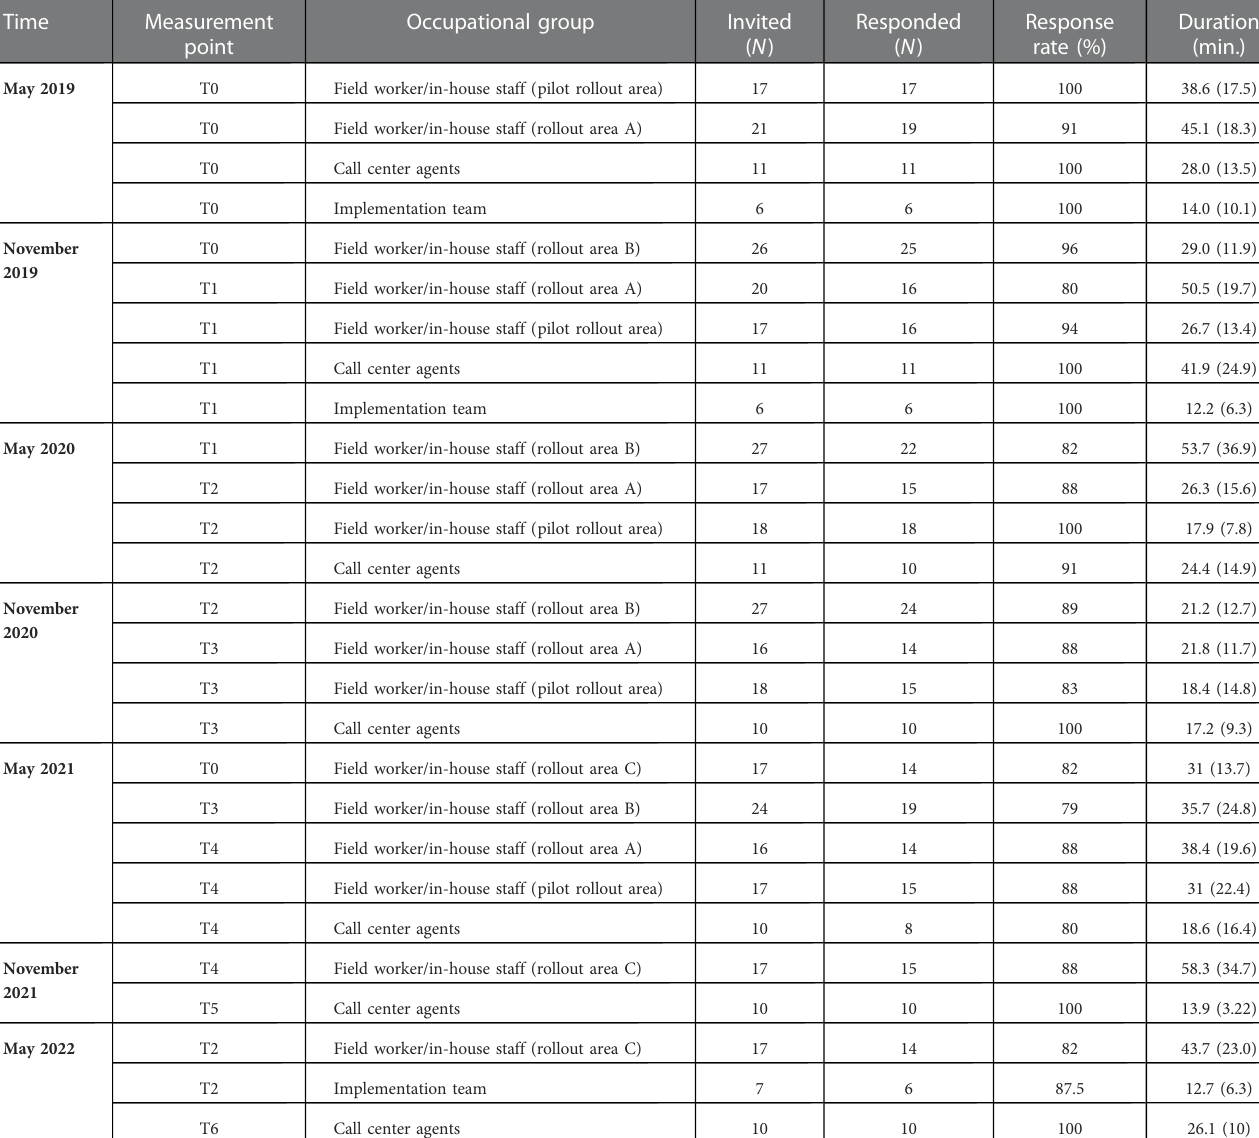
TABLE 1 Overview of employee surveys and response rates from May 2019 until May 2022 per occupational group and rollout area ( N